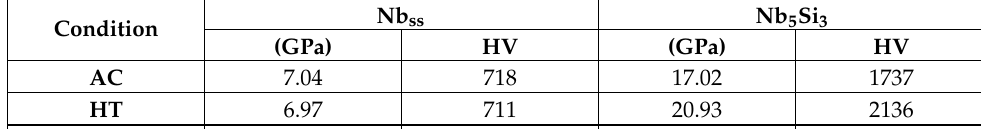
Table 8. Average nano-hardness data (GPa) and Vickers hardness (HV) values for Nb ss and Nb 5 Si 3